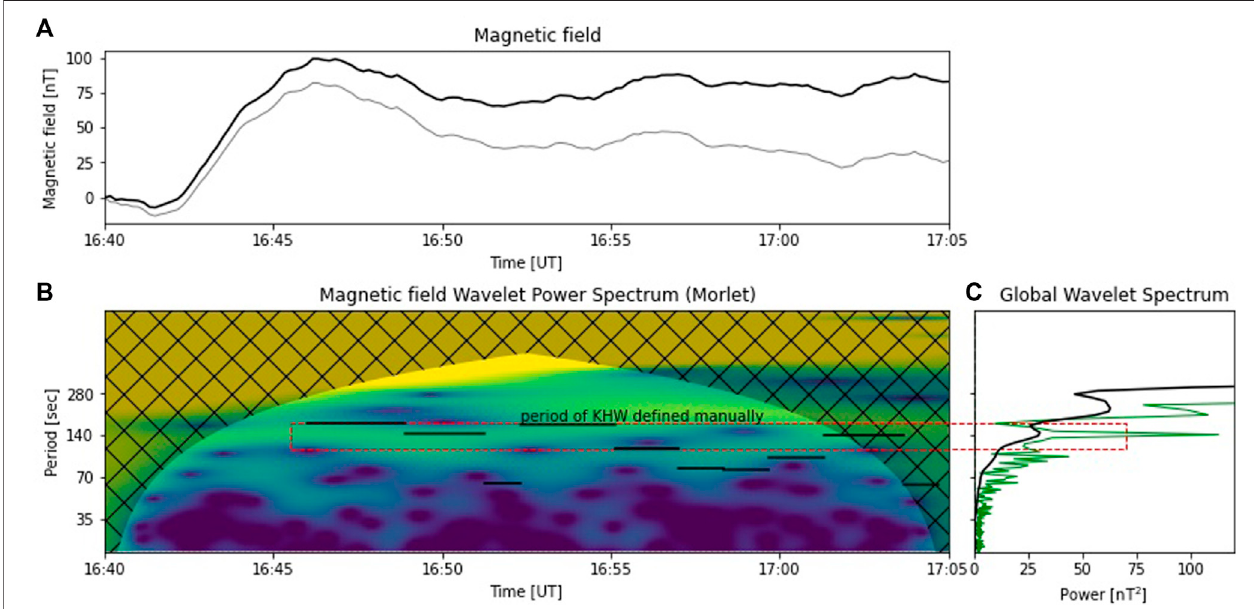
FIGURE11| Wavelettransformanalysisofthegeomagnetic fi eldoscillations at ArcticVillage, Alaska(ARC) forthe E-component, nT,between1640and 1705UT: (A) original(black)seriesandinversewavelettransform(gray),eachrelativetotheirrespectivevaluesat1640UT; (B) thenormalizedwaveletpowerspectrumandshaded COI and (C) the global wavelet for periods outside of the COI (black) and Fourier power spectra (green). Note that the period scale is logarithmic. The horizontal lines in panel (b) indicate periods of KHW de fi ned manually in Figure 3 as the time between dashed lines for corresponding time intervals. The dashed red rectangle corresponds to the period band from 113 to 173 s.